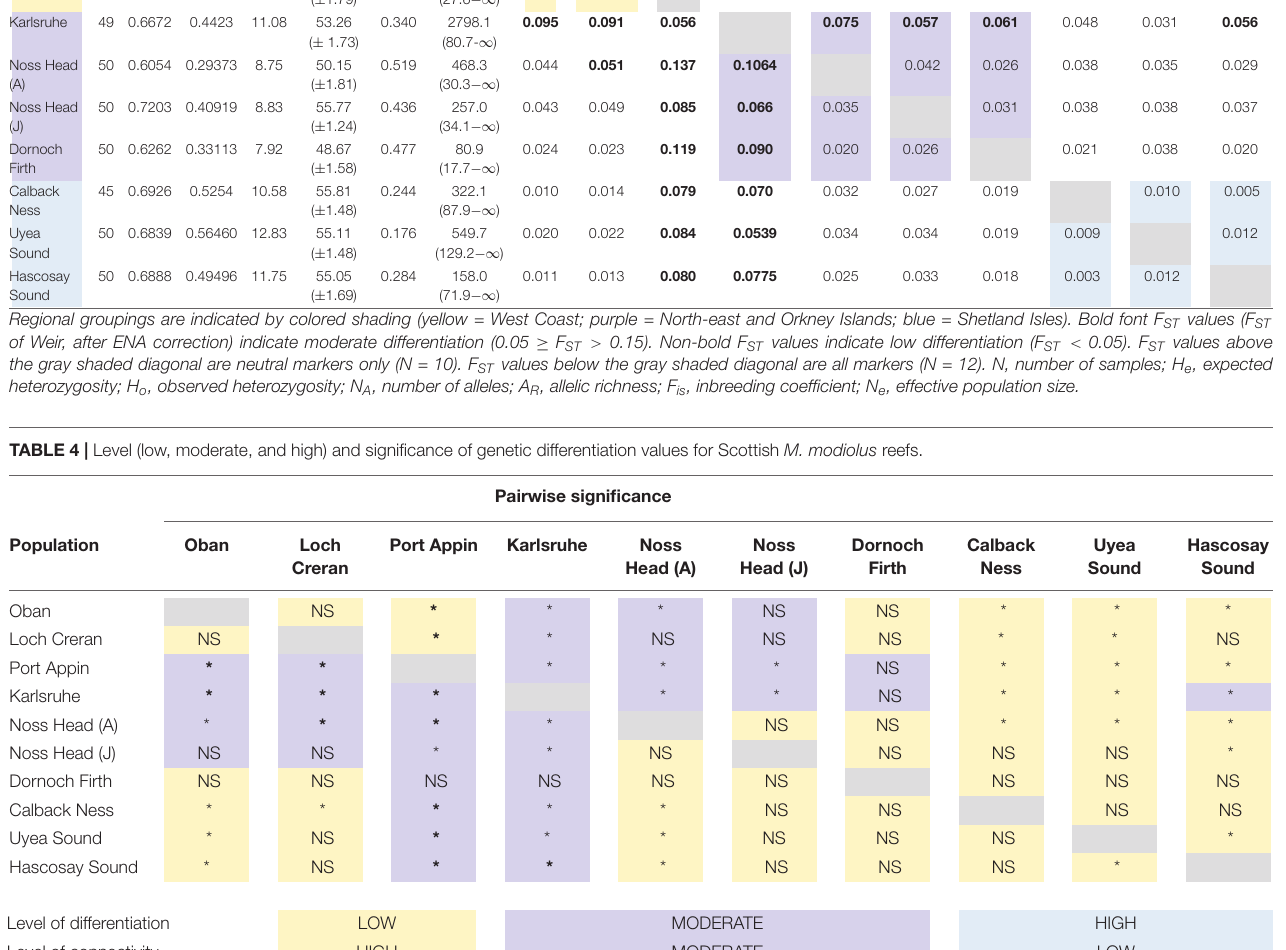
Comparison of populations within regional groups are indicated by bolded boxes. Significance levels above the gray shaded diagonal are neutral markers only (N = 10). Significance values below the gray shaded diagonal are all markers (N = 12). Level of genetic connectivity (high, moderate, low F ST scores after ENA correction) corresponding to each level of differentiation is also indicated in legend at bottom of table. *Significant; indicative adjusted nominal level (5%) for multiple comparisons is: 0.00111 following Bonferroni correction, FSTAT; NS, non-significant.